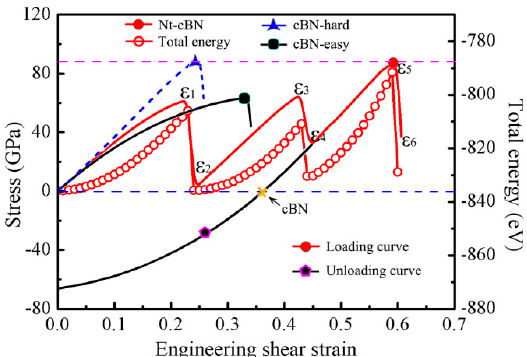
Figure 5. Calculated σ - ε and E - ε curves of nt-cBN subjected to shear straining and unloading, σ - ε curves of cBN sheared along (111) [112] easy shear direction and (111) [ 112 ] hard shear direction also provided for comparison.